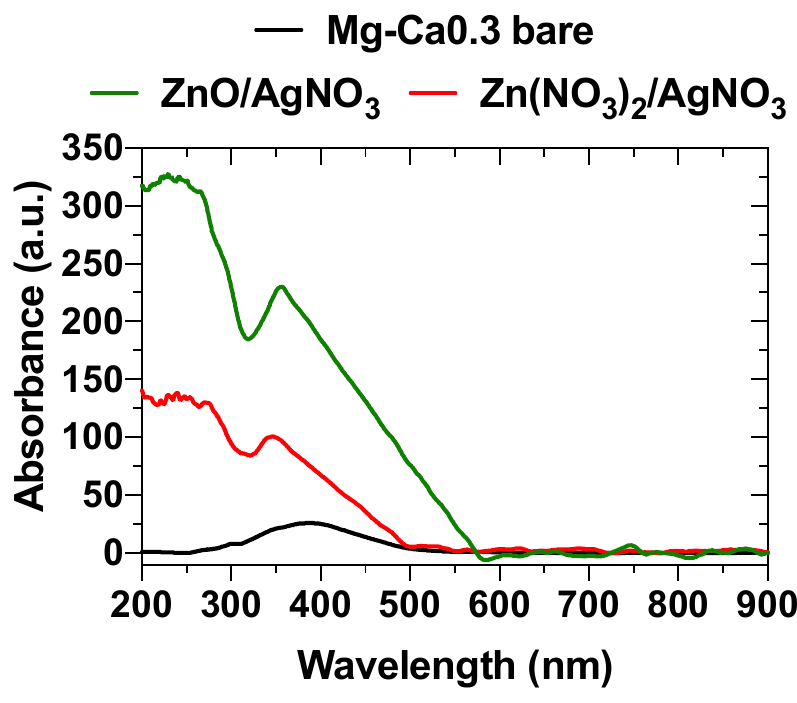
Figure 14. UV-Vis spectra of electroless hybrid ZnO/Ag-NPs deposits on Mg–Ca0.3 surfaces, electroless achieved from aqueous suspensions (10 − 3 M, at 21 °C): ZnO/AgNO 3 and Zn(NO 3 ) 2 /AgNO 3 solutions.